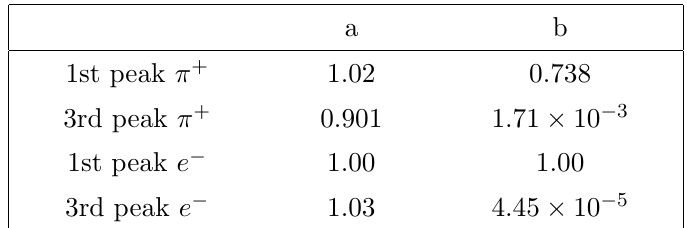
Table 3 . Best-(cid:12)t parameters of the relation E p = b ( E= GeV) a GeV, where E p is the energy of the peak shown in (cid:12)gure 8 and E is the energy of the injected